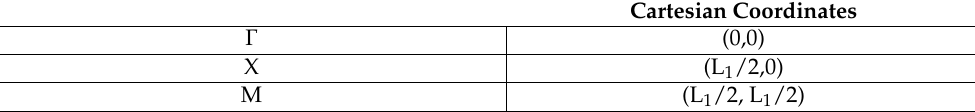
Table 1. Coordinates used for the Irreducible Brillouin Zone, see Figure 1b.